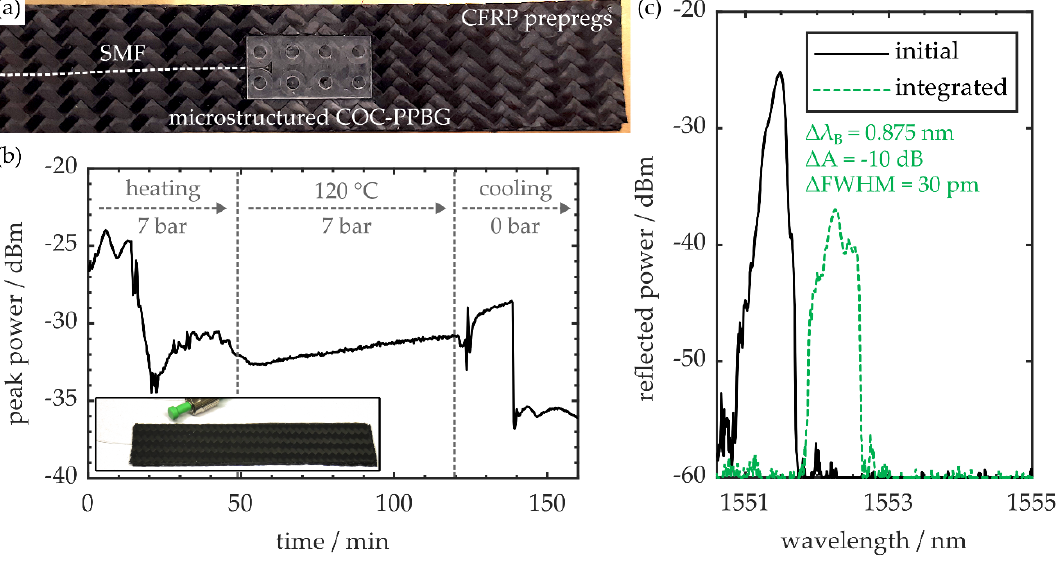
Figure 7. ( a ) COC-PPBG with a microstructure-based fiber-to-chip coupling scheme within an uncured carbon fiber reinforced polymer (CFRP) prepreg stack. ( b ) In situ monitoring of the PPBG’s peak signal power during the curing procedure. The inset shows the cured CFRP specimen with integrated polymer-optic sensor. ( c ) Reflection spectra of the PPBG prior to and after CFRP integration.